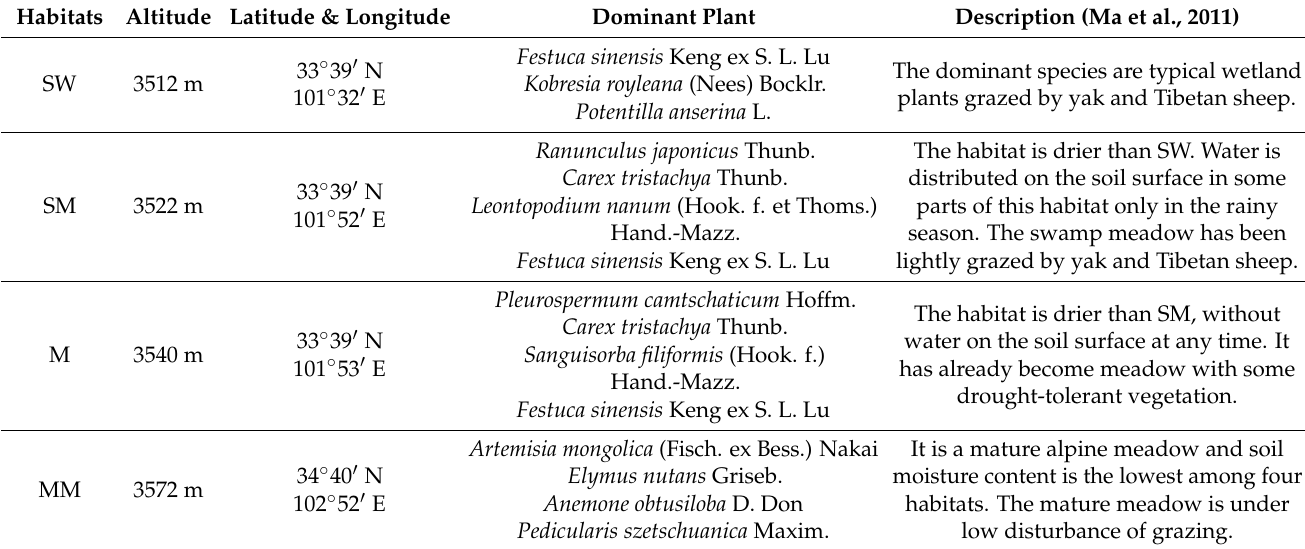
Table 1. Characteristics of the four typical alpine meadow